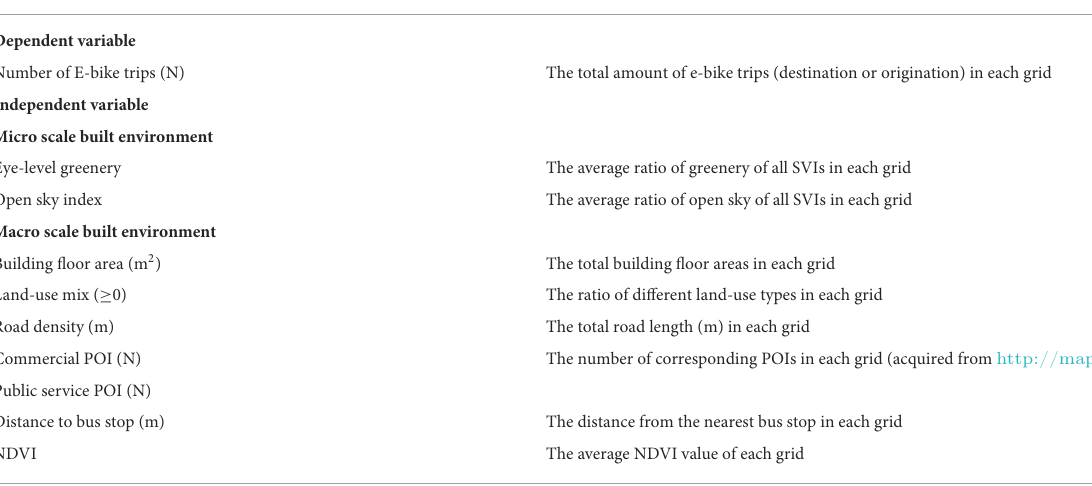
TABLE 1 Definitions of the dependent and independent